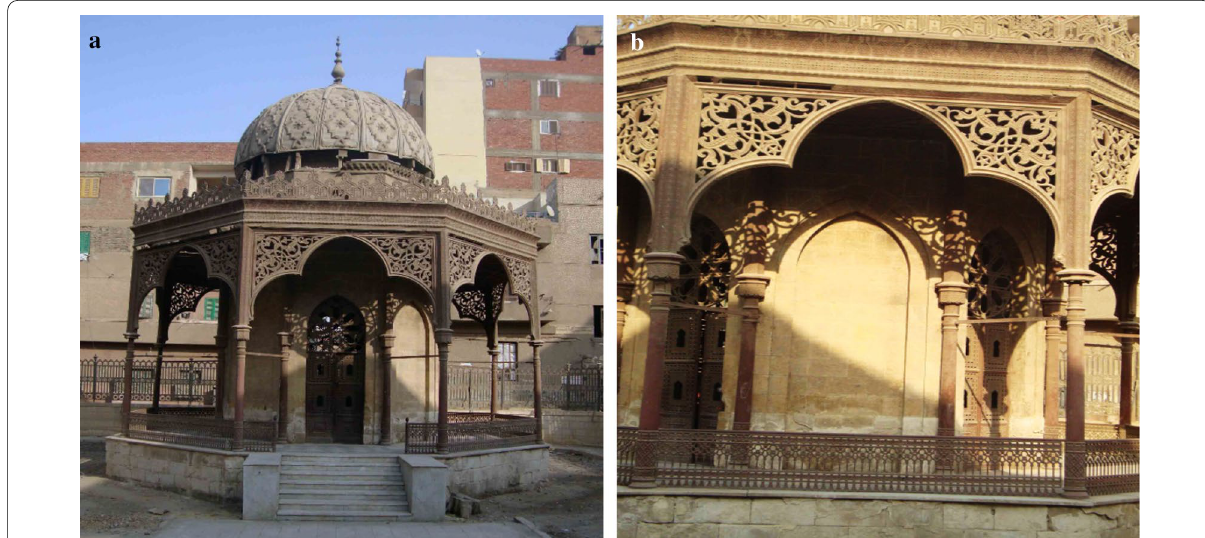
Fig. 1 a Decorative ironworks exterior the Tomb of Suleiman Pasha al‑Faransawi, and b decorative arches and columns